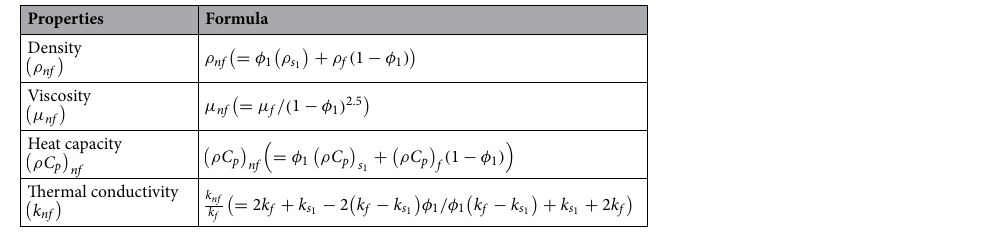
Table 1. Properties of nanofluid 43